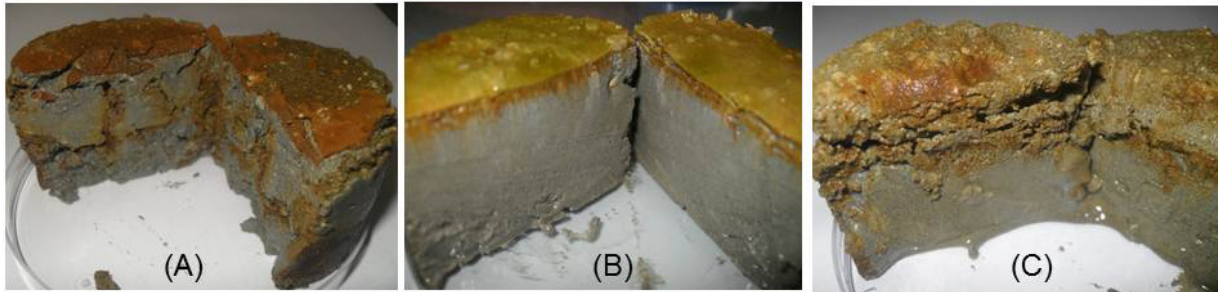
Figure 2. Mesocosms of pyritic mine tailings inoculated with mineral-oxidizing acidophilic bacteria ( A ), mineral-oxidizing and heterotrophic acidophilic bacteria and acidophilic algae ( B ) and non-inoculated controls ( C ), and incubated at 22 °C for one year